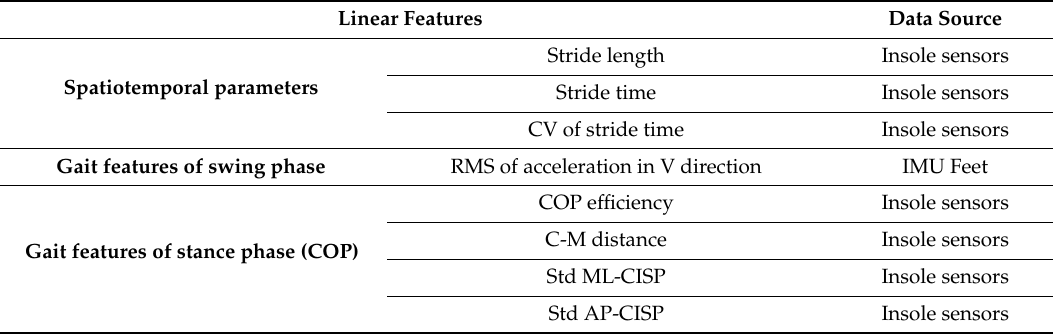
Table 2. Linear features used in this study and the data source used to calculate